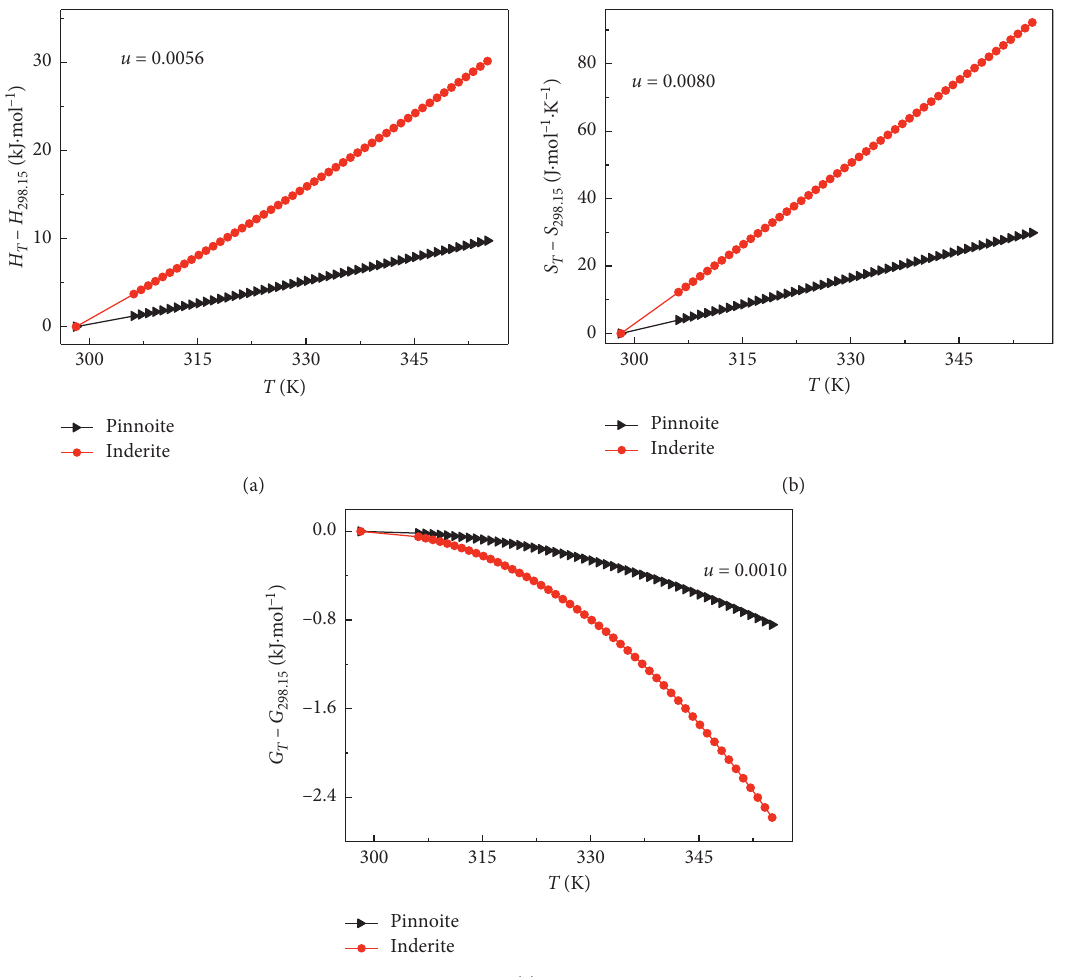
Figure 4: Variations of (a) ( H